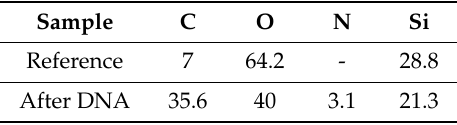
Table 2. Relative abundance (% of atoms) of the measured elements (C, O, N, Si) after each step of the immobilization protocol.